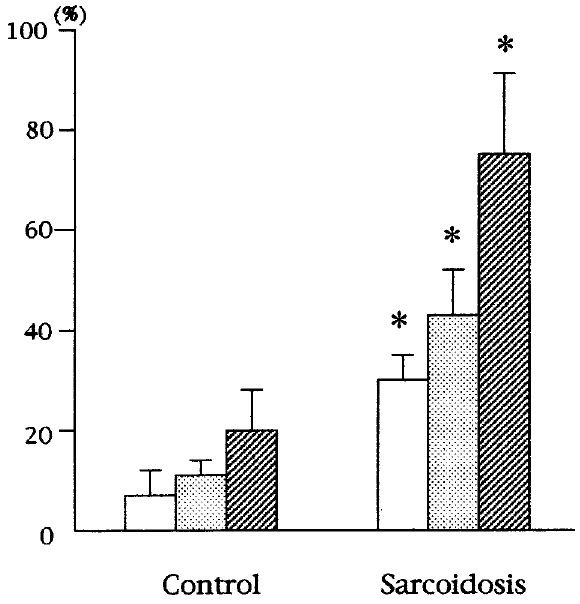
FIG. 1. Regulation of ICAM-1 expression on AM by TNF- a . AM cultured with non-treated ( h ), medium alone ( ) or TNF- a ( ). P < 0.05, compared with